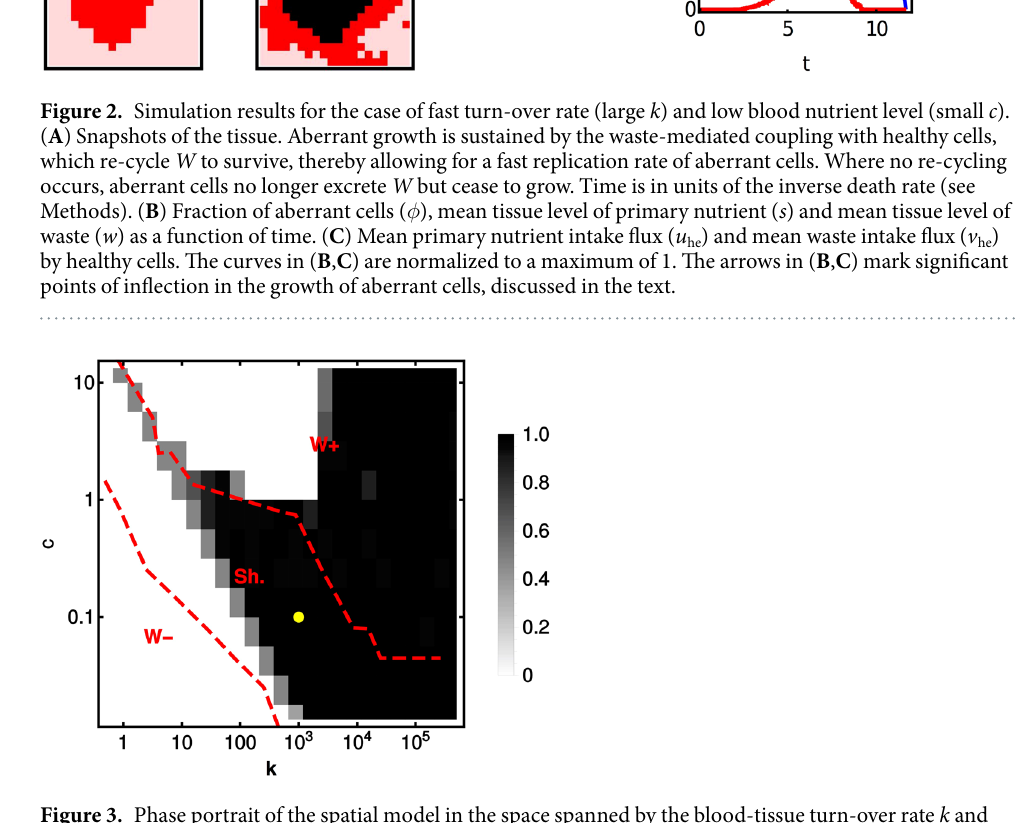
tissue as a function of c and of the effective blood-tissue turn-over rate k (averages over 20 runs). At low nutrient level and long turnover times (region labeled W − ), the primary source cannot support aberrant growth and the tissue ultimately stays healthy. In this region, no waste accumulates in the tissue and therefore no waste recycling occurs. Upon increasing k and/or c (region labeled Sh .), one enters a phase in which metabolic coupling with waste recycling occurs during the dynamics. Interestingly, though, if k gets sufficiently large, the aberrance can spread to the whole tissue, strongly implicating the metabolic coupling and/or enhanced remediation through the bloodstream as keys for tissue takeover by aberrant cells. A third regime (region labeled W + ) occurs if k or c are sufficiently large, in which healthy cells can meet their energy demand thanks to the large availability of primary substrate, so that no recycling takes place. If the increase in c is not coupled to an increase in k , waste accumulates in the tissue because blood exchange alone does not suffice to remove W ( k too low), thereby repressing aberrant growth due to increasing toxicity. As a consequence, the tissue stays healthy in the long run. On the other hand, if k also increases, aberrant cells ultimately take over the tissue as the growth-suppressing waste product is effi- ciently cleared from the tissue thanks to the high turn-over rate.